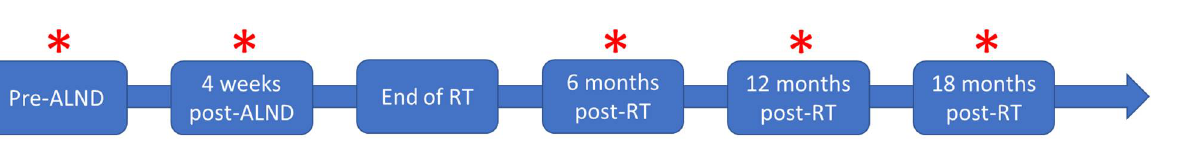
Figure 2. Longitudinal surveillance and data collection at pre-ALND, post-ALND, end of RT, and at 6-, 12-, and 18-months post-RT. Perometer arm measurements and blood samples were obtained at all visits. NIRF-LI image sessions were only conducted at pre-ALND, four weeks post-ALND, and at 6-, 12-, and 18-months post-RT (red